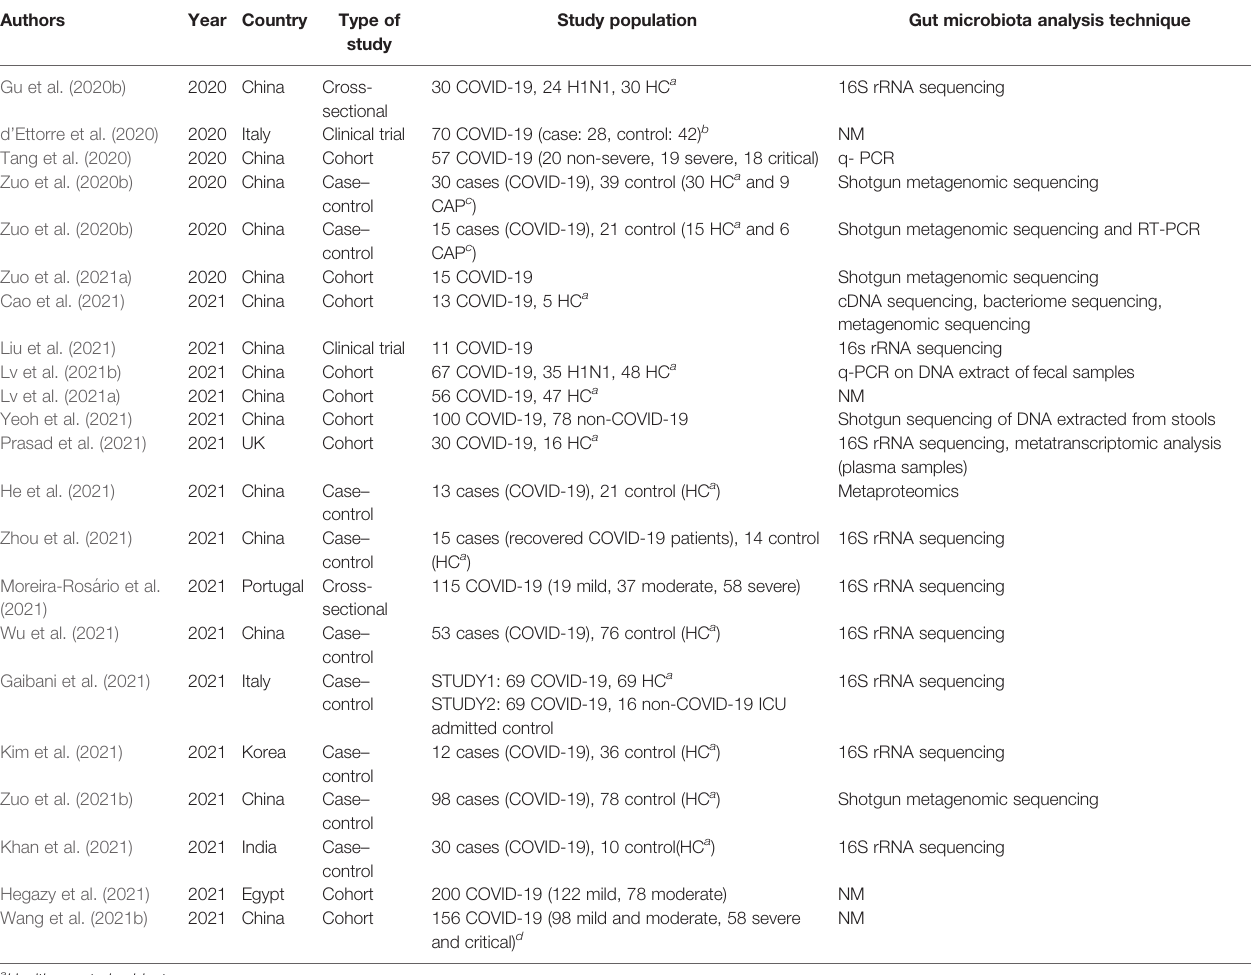
TABLE 1 | Characteristics of the included